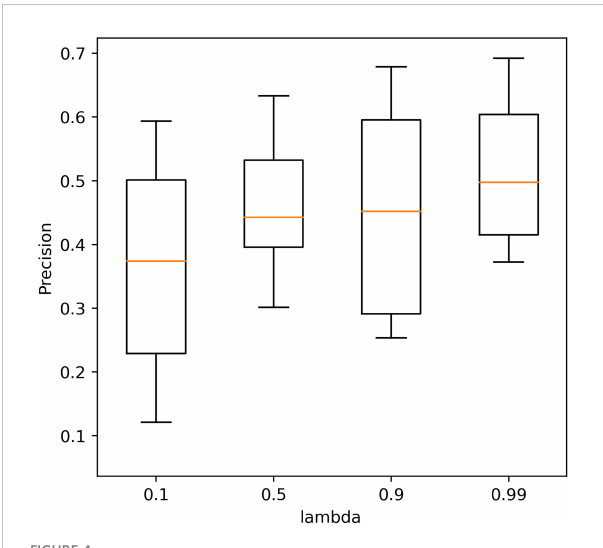
FIGURE 4 The precision of the autoencoder with different l values in 10 repeated